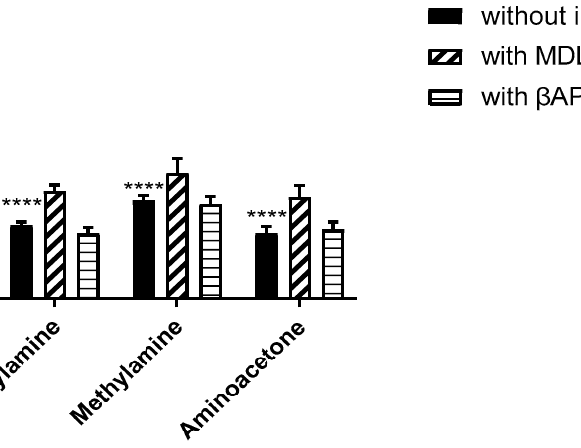
Figure 7. SSAO activity reduces total GSH (nM/mg protein) in rat aortic VSMCs. VSMCs were treated with benzylamine (500 µM), methylamine (500 µM), and aminoacetone (45 µM) (without inhibitor), and the amines in the presence of 100 µM MDL72527 (with MDL72527), and 200 µM β APN (with β APN). For cells without the inhibitor (**** p < 0.0001 for benzylamine, methylamine and aminoacetone treated cells vs control, two-way ANOVA followed by Dunnett’s); cells treated with MDL72527 (**** p < 0.0001 for benzylamine, methylamine, and aminoacetone vs control, two-way ANOVA followed by Dunnett’s); and cells treated with β APN (**** p < 0.0001 for benzylamine, methylamine and aminoacetone treated cells vs control, two-way ANOVA followed by Dunnett’s). In benzylamine, methylamine and aminoacetone treated cells there was no statistical difference between cells without inhibitor and cells treated with MDL72527 and β APN ( p > 0.05). The asterisk (*) indicates statistical significance between benzylamine, methylamine and aminoacetone treated cells vs control. Values are mean ± S.E.M. (n = 5).